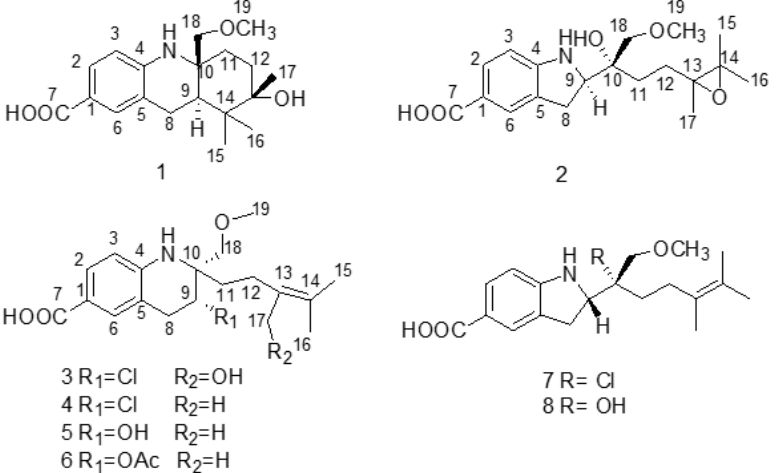
Figure 1. The structure of compounds 1 – 8 .